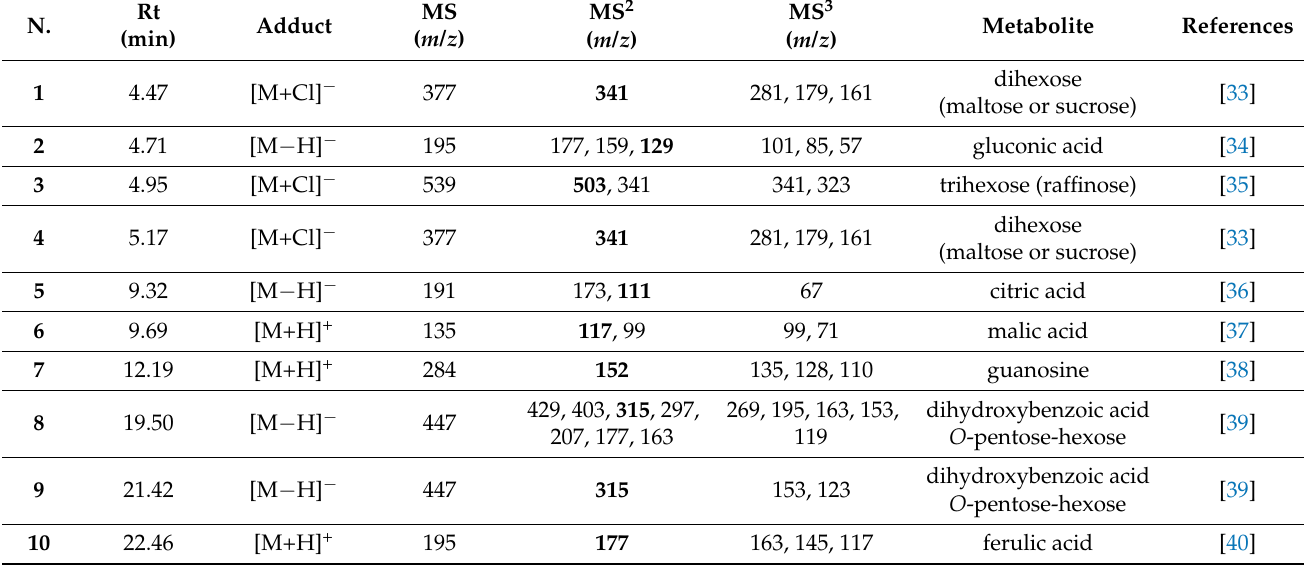
Table 2. Annotated compounds in the N. cochenillifera hydroethanolic extract by HPLC-ESI-MS n .